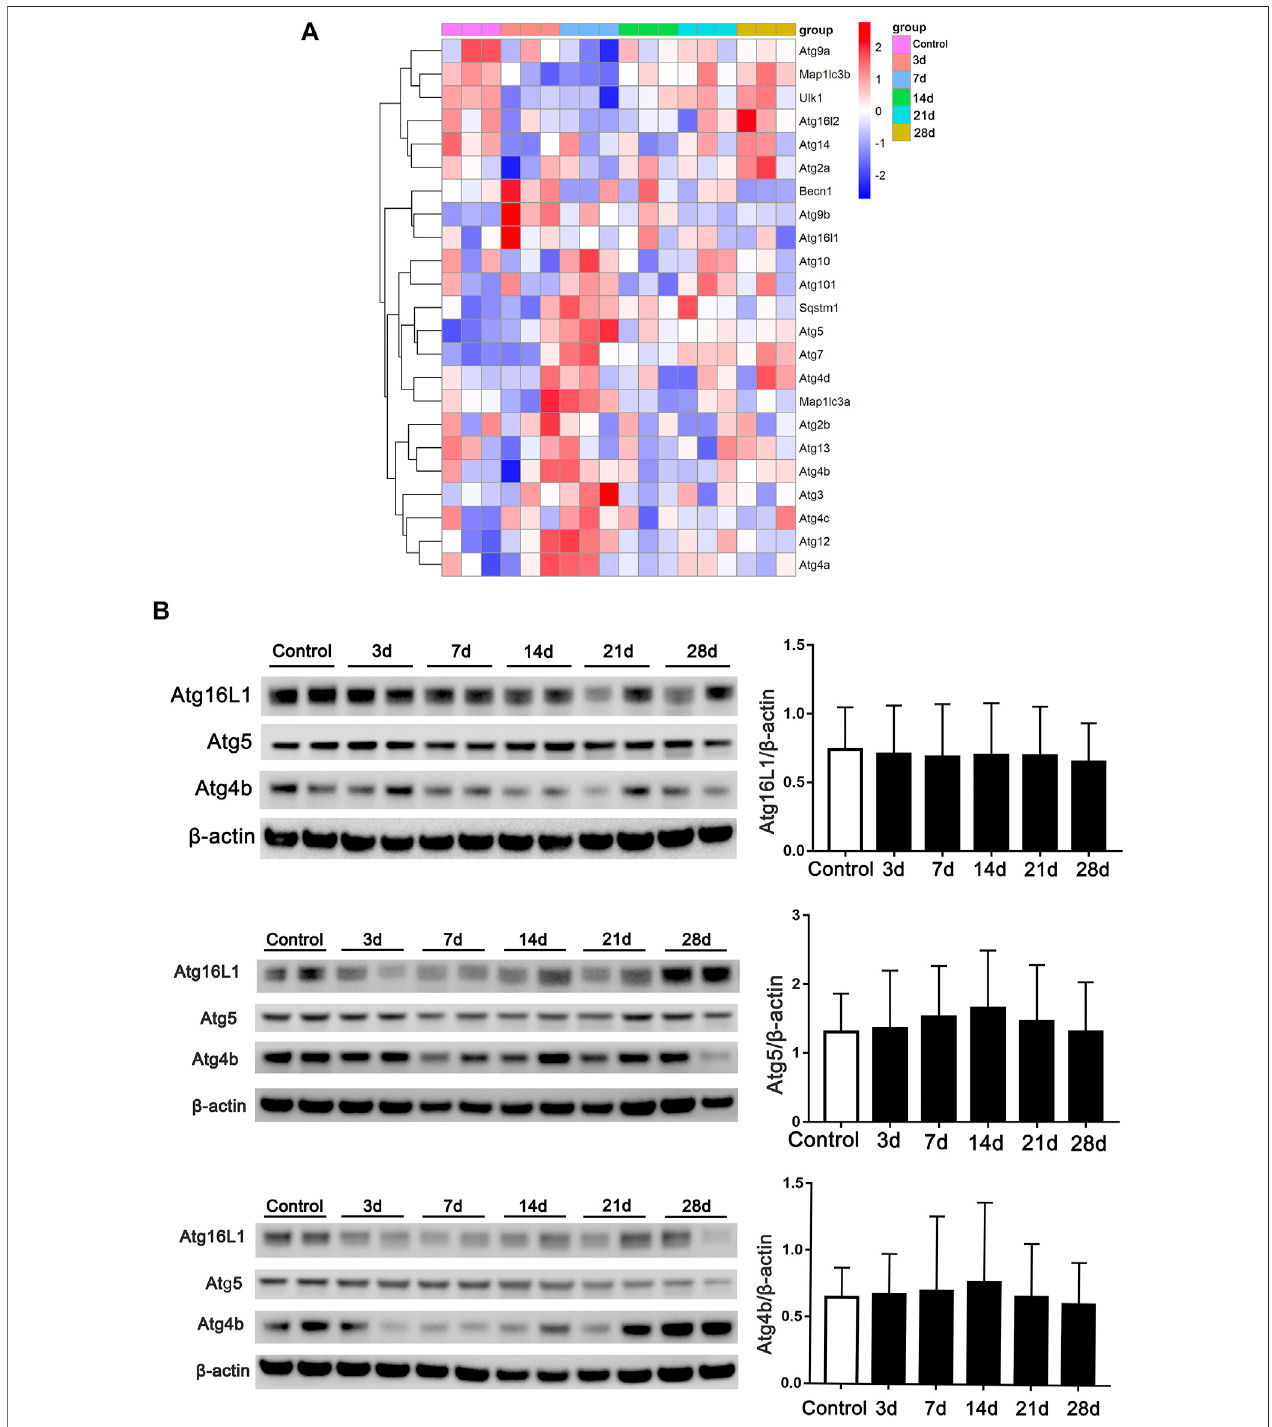
FIGURE6| Expressionofautophagy-related genesinRNA-Seq at differentstages of fi brosis. (A) Expressionofautophagy-related genesobtainedfromRNA-Seq atdifferentstagesof fi brosis. (B) Validationofautophagy-relatedgenesandsemiquanti fi cation( n (cid:2) 6)byWesternblot.Mouselungtissuewascollectedandsubjectedto Western blotting using the indicated